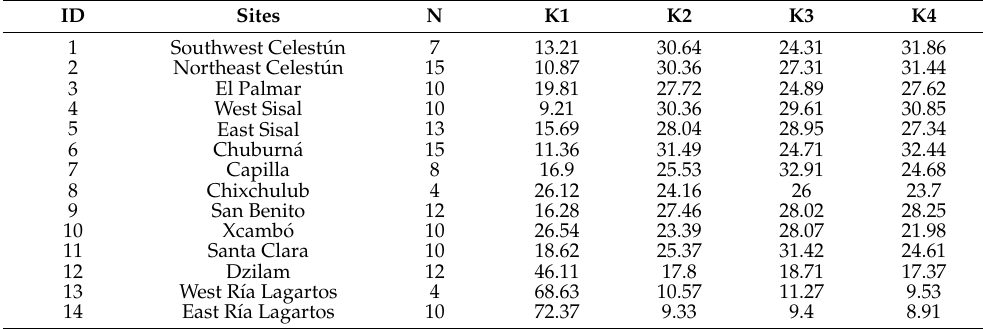
Table A3. Assignment probability (%) of sampling sites to four genetic groups identified in Structure (K = 4) of Campylorhynchus yucatanicus in the northern Yucatan Peninsula, Mexico.